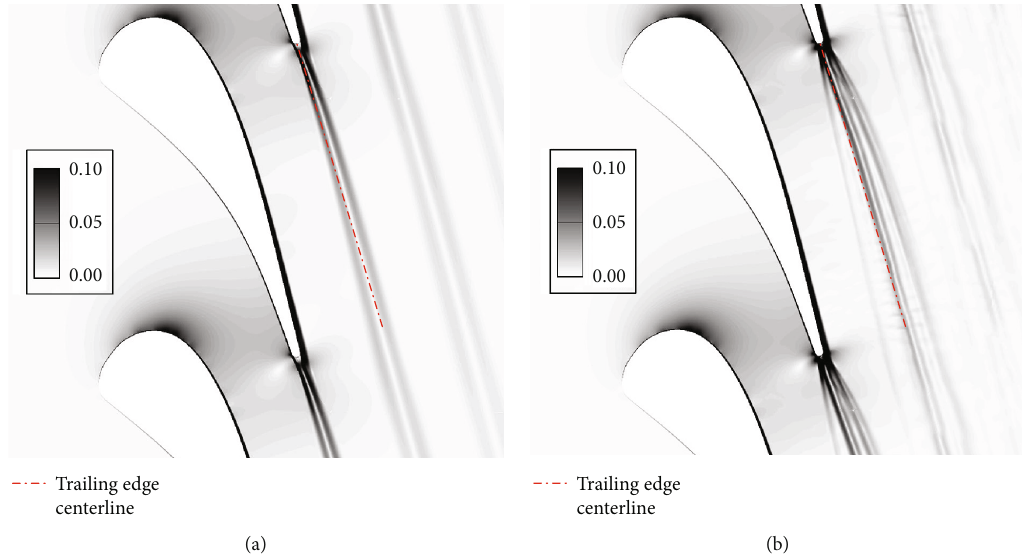
Figure 13: Comparison of density gradient contours of MUR129: (a) SST-RANS result; (b) time-averaged result of present